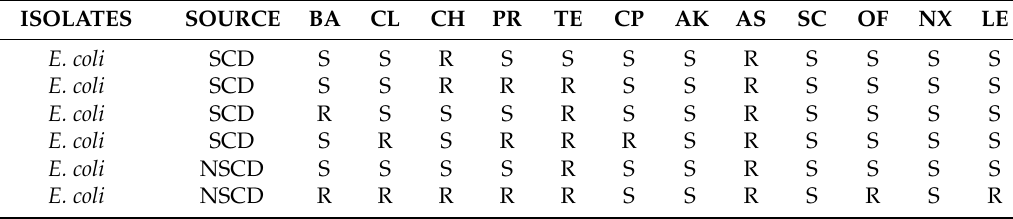
Table 3. Antibiogram of urinary bacterial isolates from SCD patients and healthy controls. ISOLATES SOURCE BA CL CH PR TE CP AK AS SC OF E.